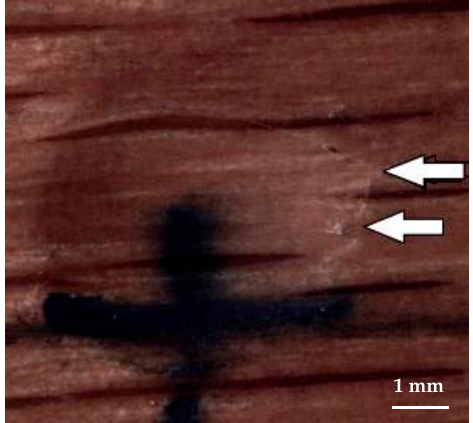
Figure 5. Cracking visible on the surface with surface finish of linseed oil + oil on thermally modified wood (TMW 195 °C) after impact resistance testing at the drop height of 400 mm.